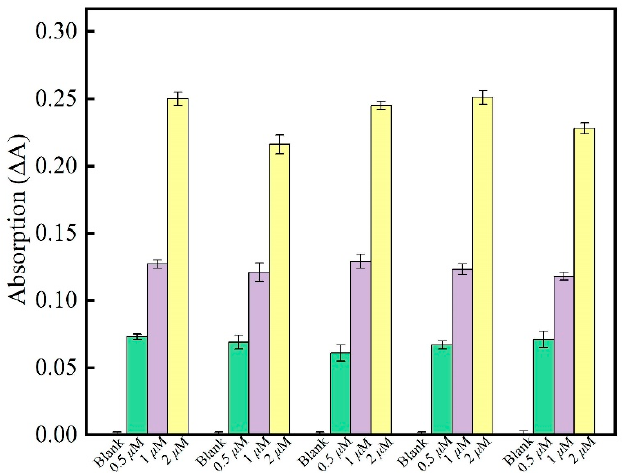
Figure 5. The UV absorption peaks of RDV were obtained by adding blood containing different concentrations of N protein added to the MSN-Au solution of the same concentration and